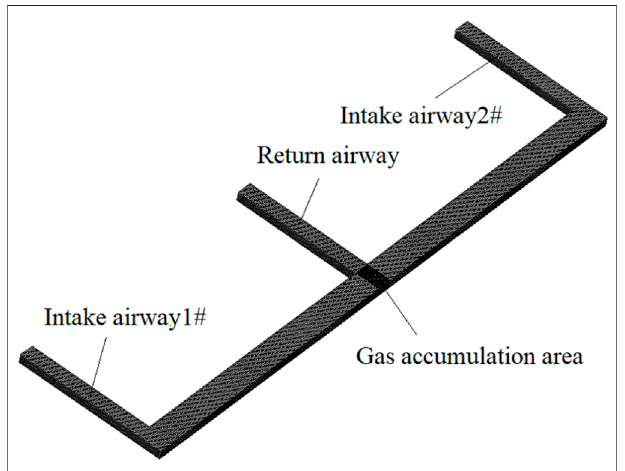
FIGURE 2 | Three-dimensional physical model of W-type ventilation.